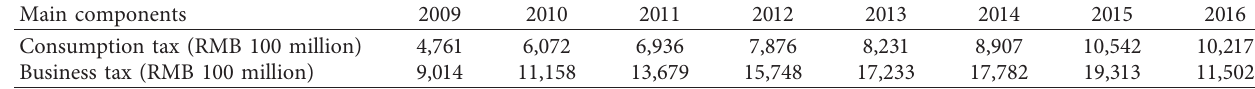
Table 1: Domestic consumption tax and business tax income (2009–2016).